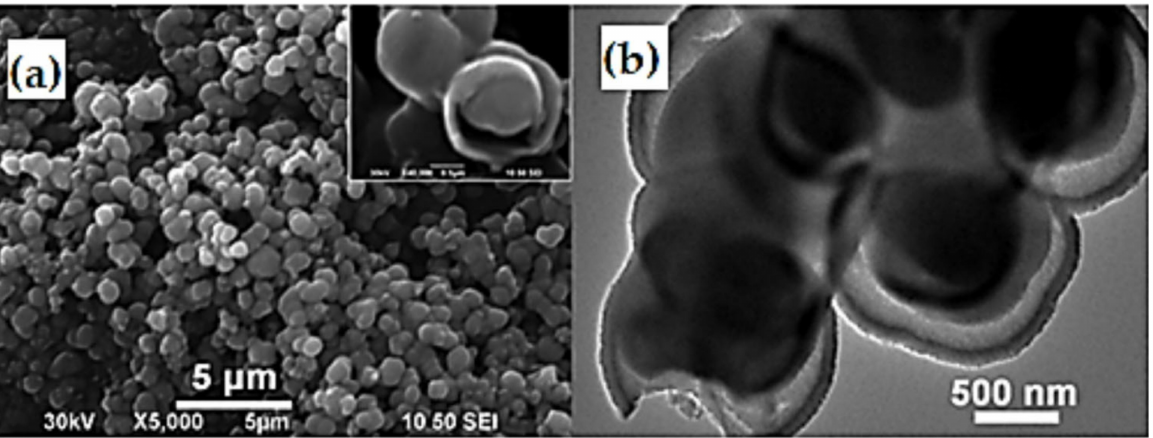
Figure 13. ( a ) SEM and ( b ) TEM images of yolk-shell TiO 2 . Reprinted with permission from Ref. [96]. Copyright 2014